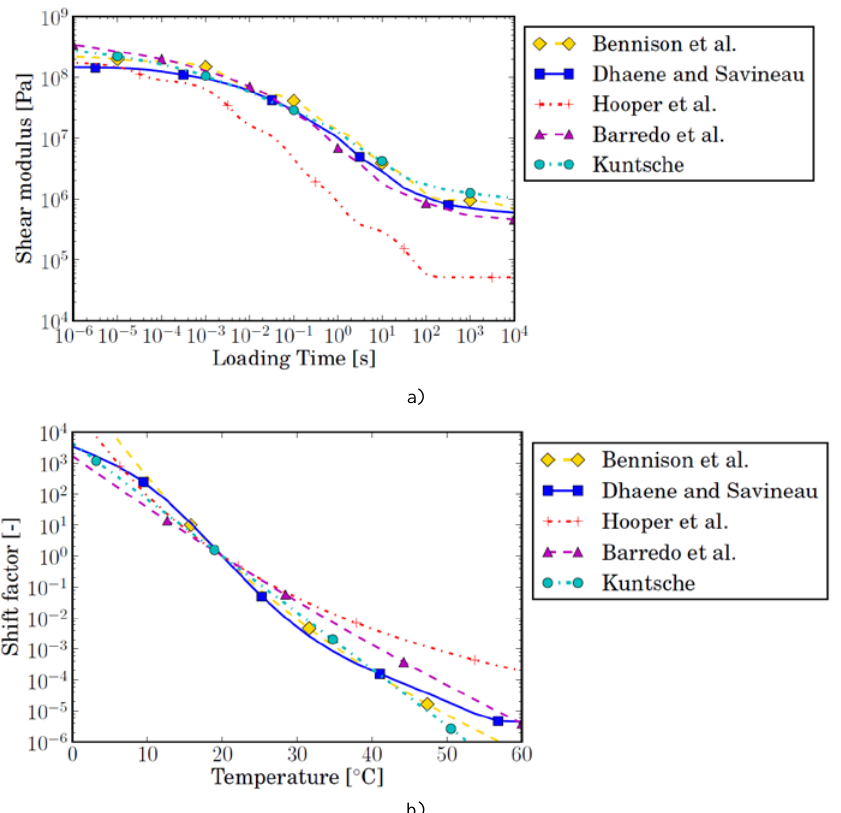
Fig. 2 Relaxation stiffness of PVB in literature: (a) shear modulus at reference temperature T = 20°C, and (b) temperature-time shift